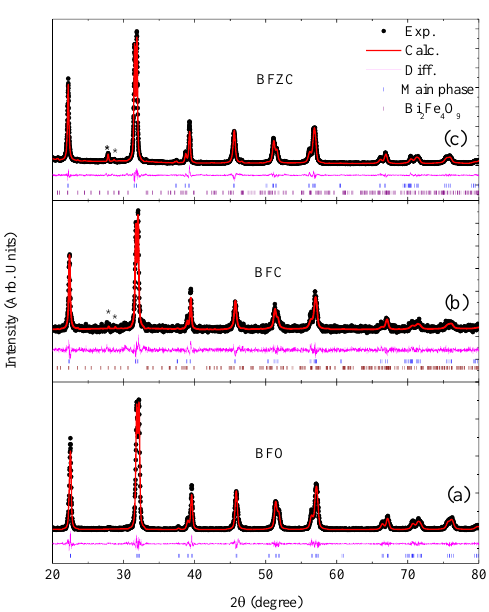
Figure 1. The refined XRD patterns of the samples. * indicate some peaks, characteristic of Bi 2 Fe 4 O 9 phases. ( a ) BFO, ( b ) BFC, ( c ) BFZC. A comparison between the magnetic hysteresis loop of BFC and of BFZC measured